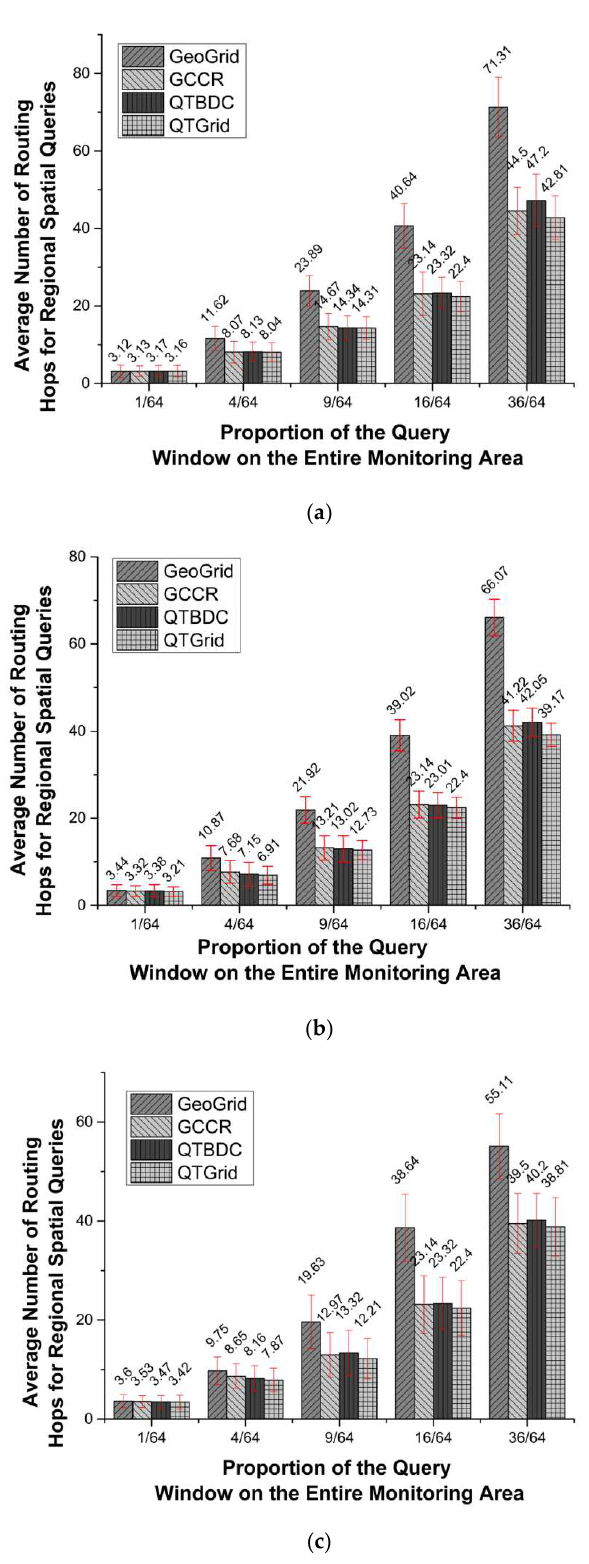
Figure 11. The comparison of an average number of routing hops for the spatial query. ( a ) Network with 200 nodes; ( b ) network with 400 nodes; ( c ) network with 800